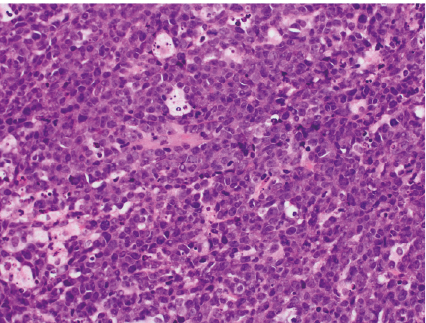
Figure 4: Biopsy (hematoxylin and eosin stain) showing a classic “starry sky” appearance consistent with Burkitt’s lymphoma.